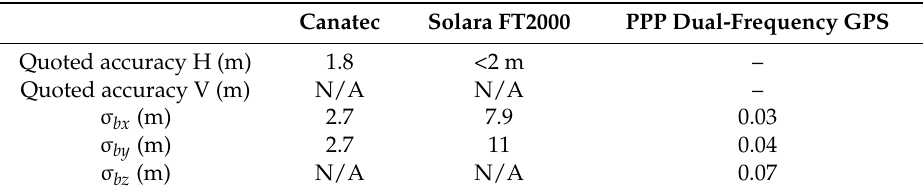
Table 1. Quoted accuracies and calculated positional uncertainties used in data processing for Canatec beacons units [47], Solara FT2000 tracking beacons [48] and higher-quality, dual-frequency GPS following Precise Point Positioning (PPP) processing using Natural Resource Canada’s online tool [45,49].